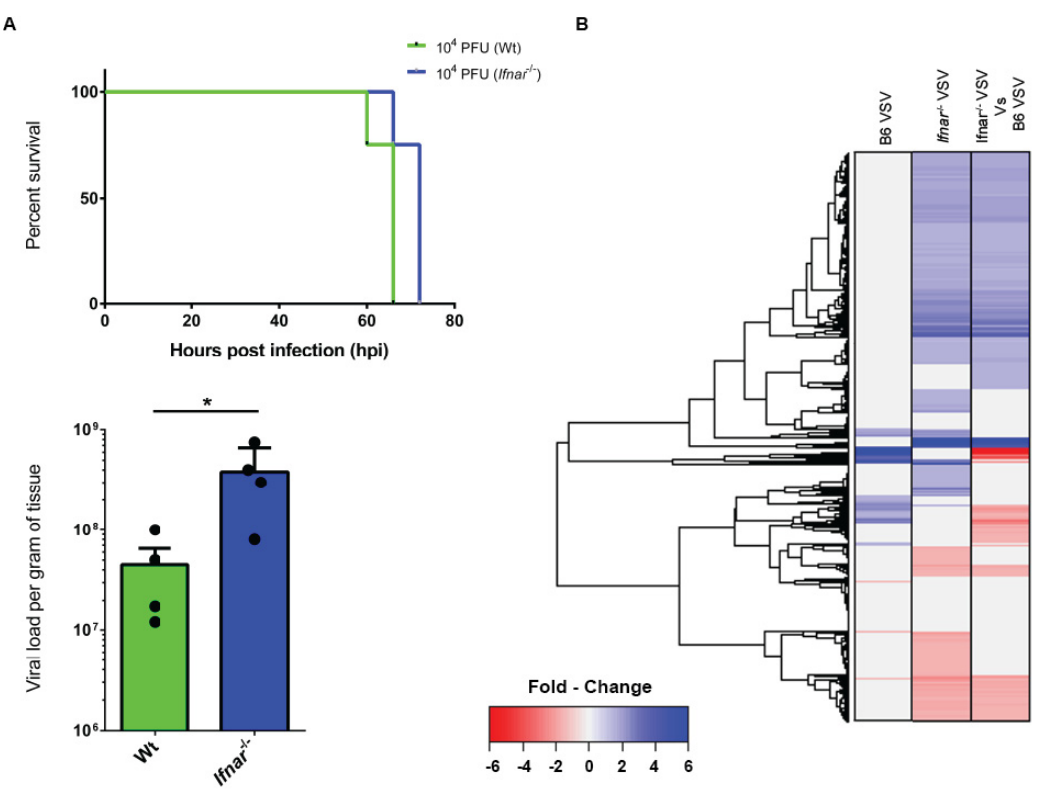
Figure 4. VSV infection induces a massive change in the gene expression in the absence of type I interferon. Ifnar − / − mice ( n = 4 per group) were intracerebrally infected with the VSV to induce encephalitis, and comparative CNS gene microarray analysis was performed along with the wild type mice. ( A ) The upper subset represents a Kaplan–Meier survival curve of animals, which shows a marginal delay in onset death in Ifnar − / − mice. While the lower subset represents the brain viral titers determined by plaque assay, which shows a significant increase ( p < 0.05) in brain viral load in Ifnar − / − mice. * denotes p -value < 0.05 ( B ) Global heat map depicting the change in gene expression patterns and clustered based on functional relatedness (see corresponding Table S1). The change in expression level is depicted by blue (upregulation pattern), red (downregulation pattern), and gray (no change in the